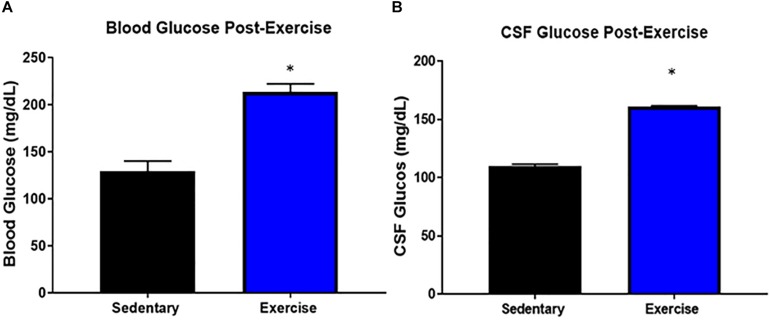
Blood and CSF glucose levels were elevated immediately post-exercise. Average circulating glucose levels in (A) blood and (B) CSF of mice immediately after a bout of acute moderate-intensity exercise. Bar graphs show Mean + SEM. (N = 3 male mice per group), * indicates p < 0.05 vs. sedentary group.